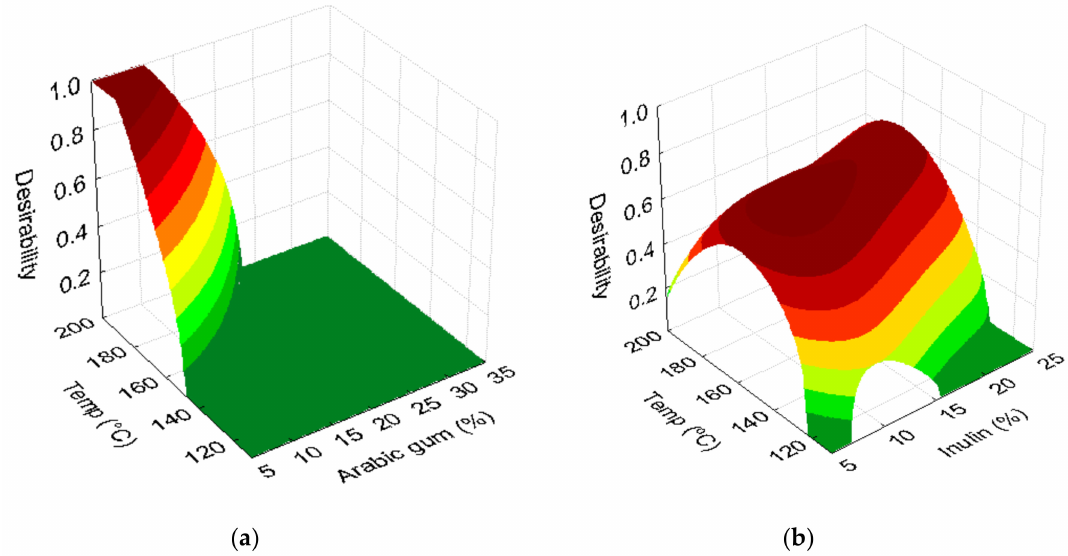
Figure 4. Desirability surface curves for optimal conditions: ( a ) Using EE and DY for arabic gum assays; ( b ) using EE, LC, and DY for inulin